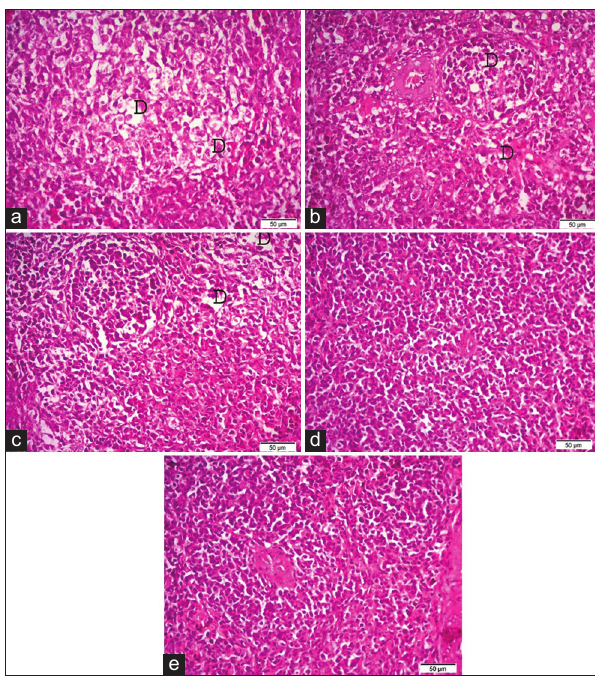
Figure-5: Photomicrographs of hematoxylin and eosin (H&E) stained sections of the spleen (a) the spleen of G1 (broilers supplemented with 0.5 g/L Bacillus subtilis ) showing severe depletion of lymphoid follicles (D). (b) The spleen of G2 (broilers supplemented with 1.0* g/L B. subtilis ). (c) The spleen of G3 (broilers supplemented with 1.5 g/L B. subtilis ). (d) The spleen of G4 (broilers supplemented with 2.0 g/L B. subtilis ). (e) The spleen of G5 (control group). H&E (40×). Bar 50 µ